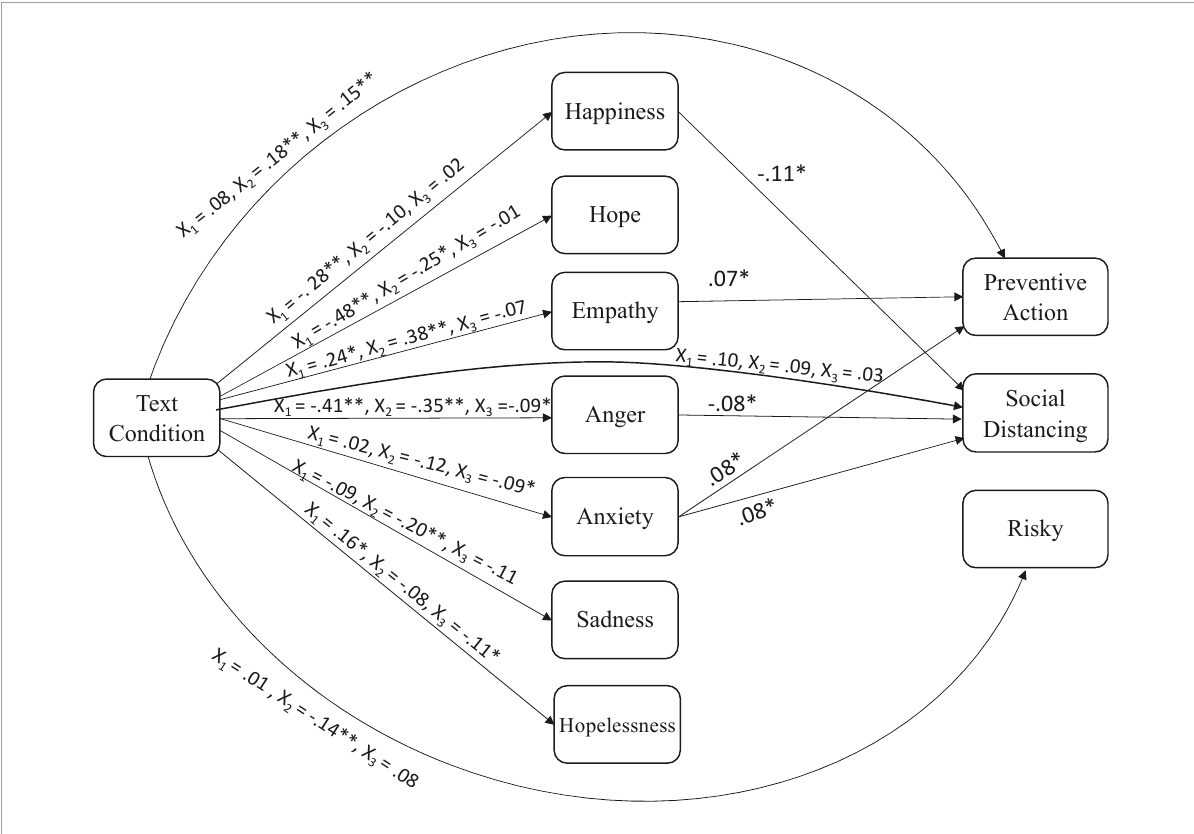
FIGURE4 Model of relations between text condition, emotions, and actual engagement in preventive action. Standardized effects; only significant paths are shown for emotions to outcomes to reduce complexity. * p < 0.05 and ** p < 0.01.